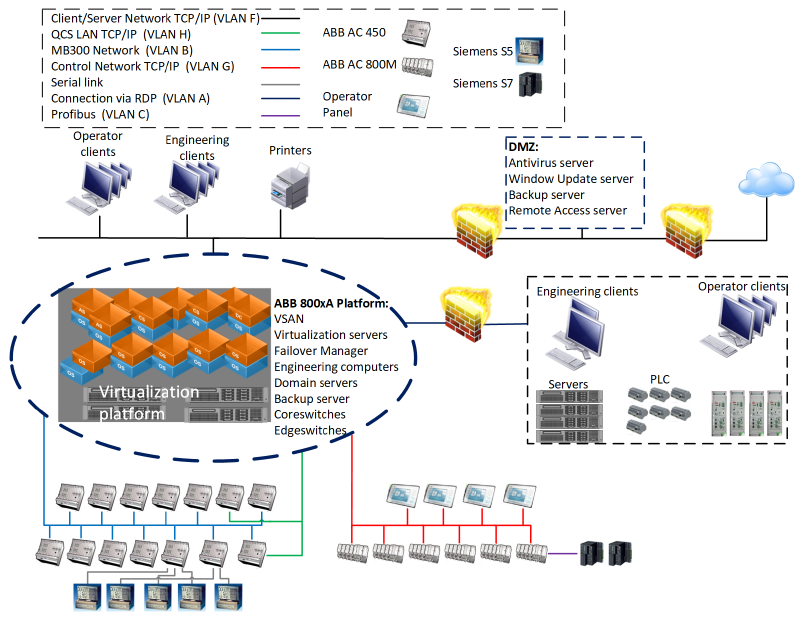
Figure 1. Network topology at one of the paperboard machines at Iggesund based on the documen- tation